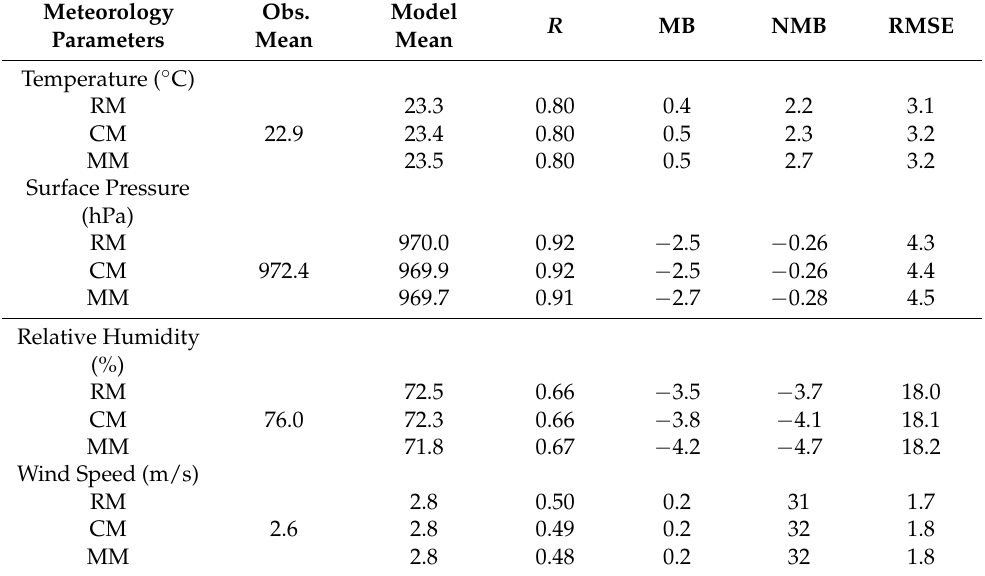
Table 3. Statistical analysis of hourly meteorological variables during the month of July 2010 for the RACM-MADE/SORGAM (RM), CBMZ-MOSAIC (CM), and MOZART-MOSAIC (MM) chemistry- aerosol mechanisms. All stations considered have ≥ 90% of available hourly